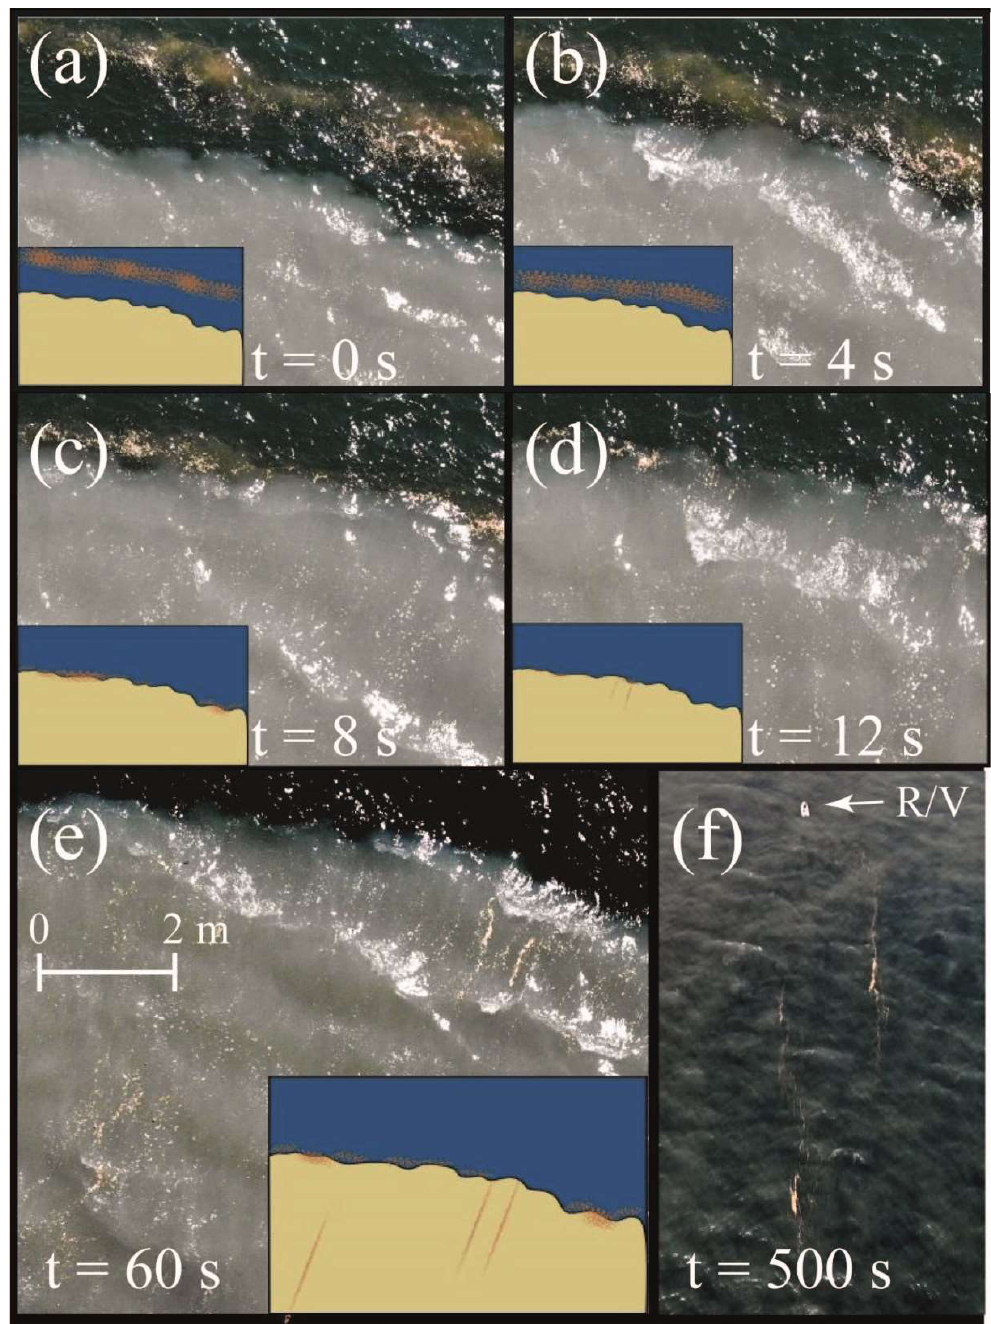
Figure 10. Aerial images of the Bzyb plume border on 15 April 2021 at ( a ) the beginning of the “cross-border” experiment, ( b ) after 4 s, ( c ) after 8 s, ( d ) after 12 s, ( e ) after 60 s, and ( f ) after 500 s illustrating the Stokes drift of sawdust particles across the plume-sea interface in the fine surface layer. The insets illustrate the location of sawdust particles (indicated by orange dots) in relation to the plume border. Note that panel ( f ) is not a nadir image and it has a significantly larger scale than those in panels ( a – d ).